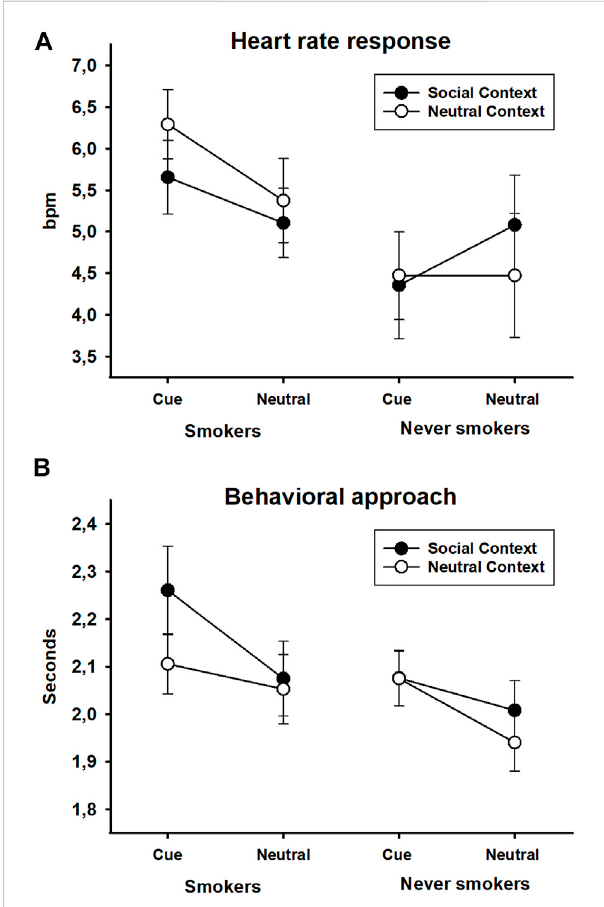
FIGURE 7 Heart rate responses (bpm) (A) and behavioral approach responses (time to target contact in seconds) (B) to smoking and neutral stimuli presented in a social or neutral context in smokers and